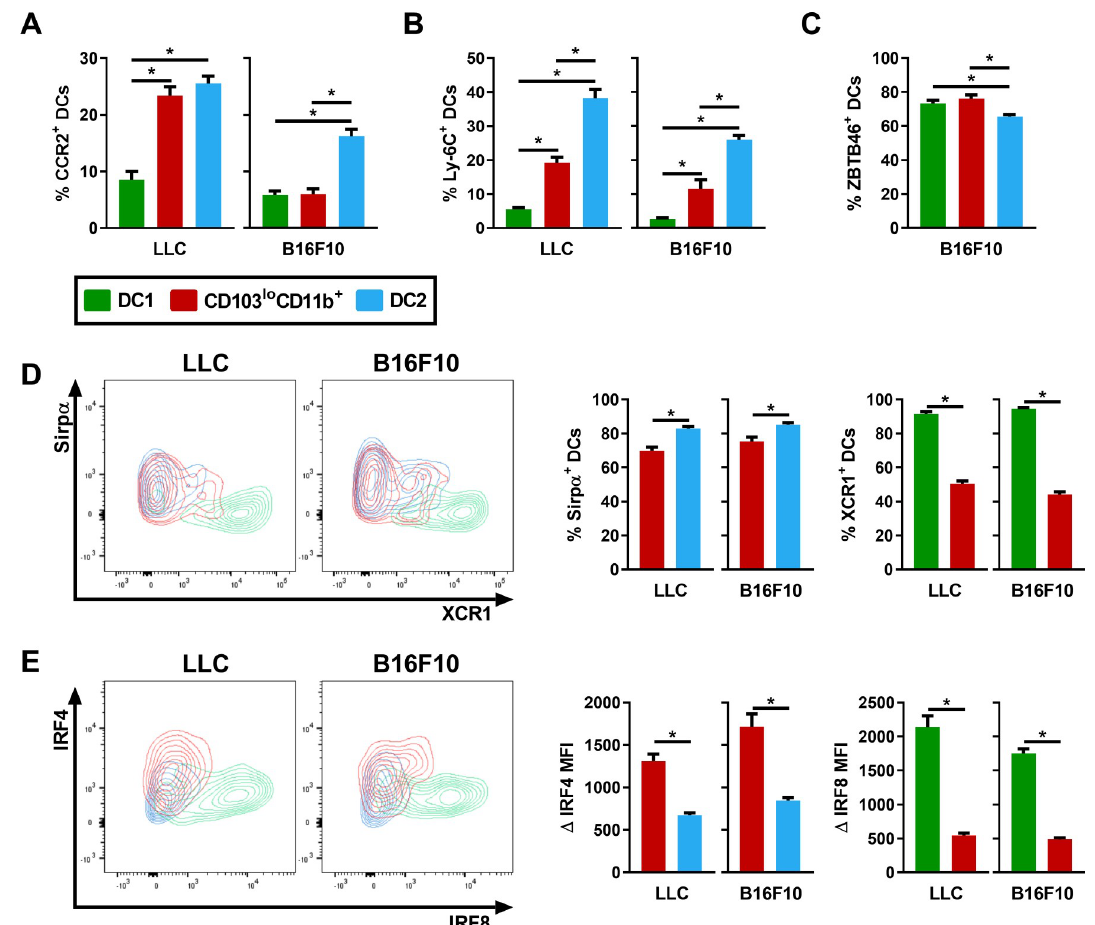
Fig 4. CD103 lo CD11b + DCs express markers of the DC2 population. Surface markers and transcription factors expression were analyzed by flow cytometry and compared between lung DC1 (green), CD103 lo CD11b + DC (red) and DC2 (blue) populations following the i.v. injection of LLC or B16F10 cells. Percentage of (A) CCR2 + , (B) Ly-6C + and (C) ZBTB46 + cells for each subpopulation of DCs. (D) Representative contour plots of Sirp α and XCR1 expression of each DC subpopulation, as well as the percentage of Sirp α + cells in CD103 lo CD11b + DCs (red) and DC2s (blue), and the percentage of XCR1 + cells in DC1s (green) and CD103 lo CD11b + DCs (red). (E) Representative contour plots of IRF4 and IRF8 expression, as well as Δ IRF4 MFI in CD103 lo CD11b + DCs (red) and DC2s (blue), and Δ IRF8 MFI in DC1s (green) and CD103 lo CD11b + DCs (red). Data are expressed as mean ± SEM. (A-B-E) n = 5–8 mice per group and are representative of two independent experiments. (C-D) n = 11–14 pooled from two independent experiments. � = p < 0.05, (A-B-C) using repeated measures one-way ANOVA, with the Geisser-Greenhouse correction followed by Tukey’s multiple comparisons test and (D-E) using a paired